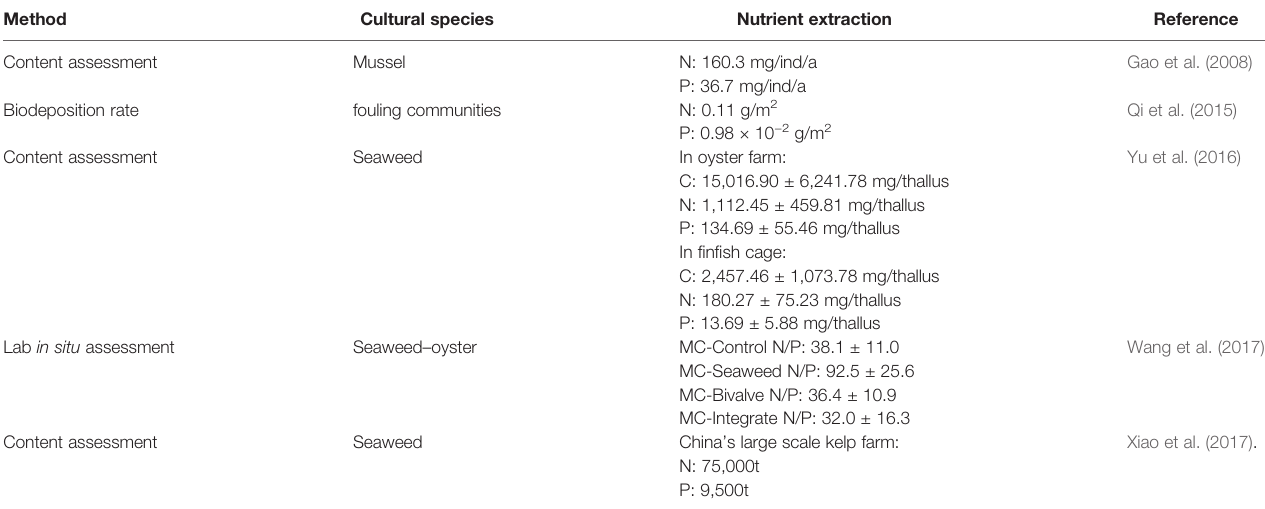
TABLE 1 | Nutrient extraction assessment of mariculture in